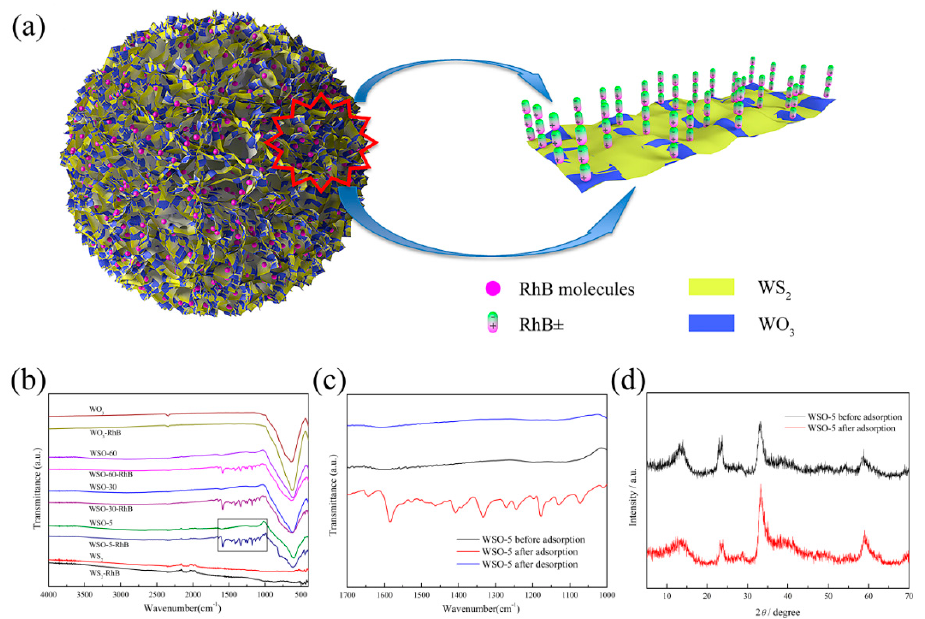
Figure 12. ( a ) The adsorption mechanism of WSO-5 microflowers toward RhB; ( b ) the FTIR spectra of WS 2 , WS 2 /WO 3 , and WO 3 before and after the adsorption of RhB dye; ( c ) The enlarged image of WSO-5 of the zone marked in ( b ); and ( d ) the XRD patterns of WSO-5 before and after the adsorption of RhB dye.